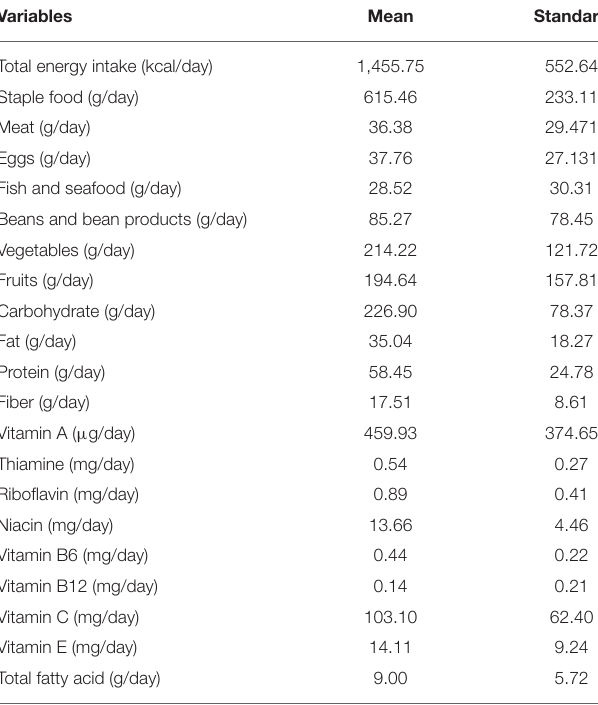
TABLE 2 | Demographic information of OOPS from 2015 to June 2020. TABLE 3 | Diet information of OOPS from 2015 to June